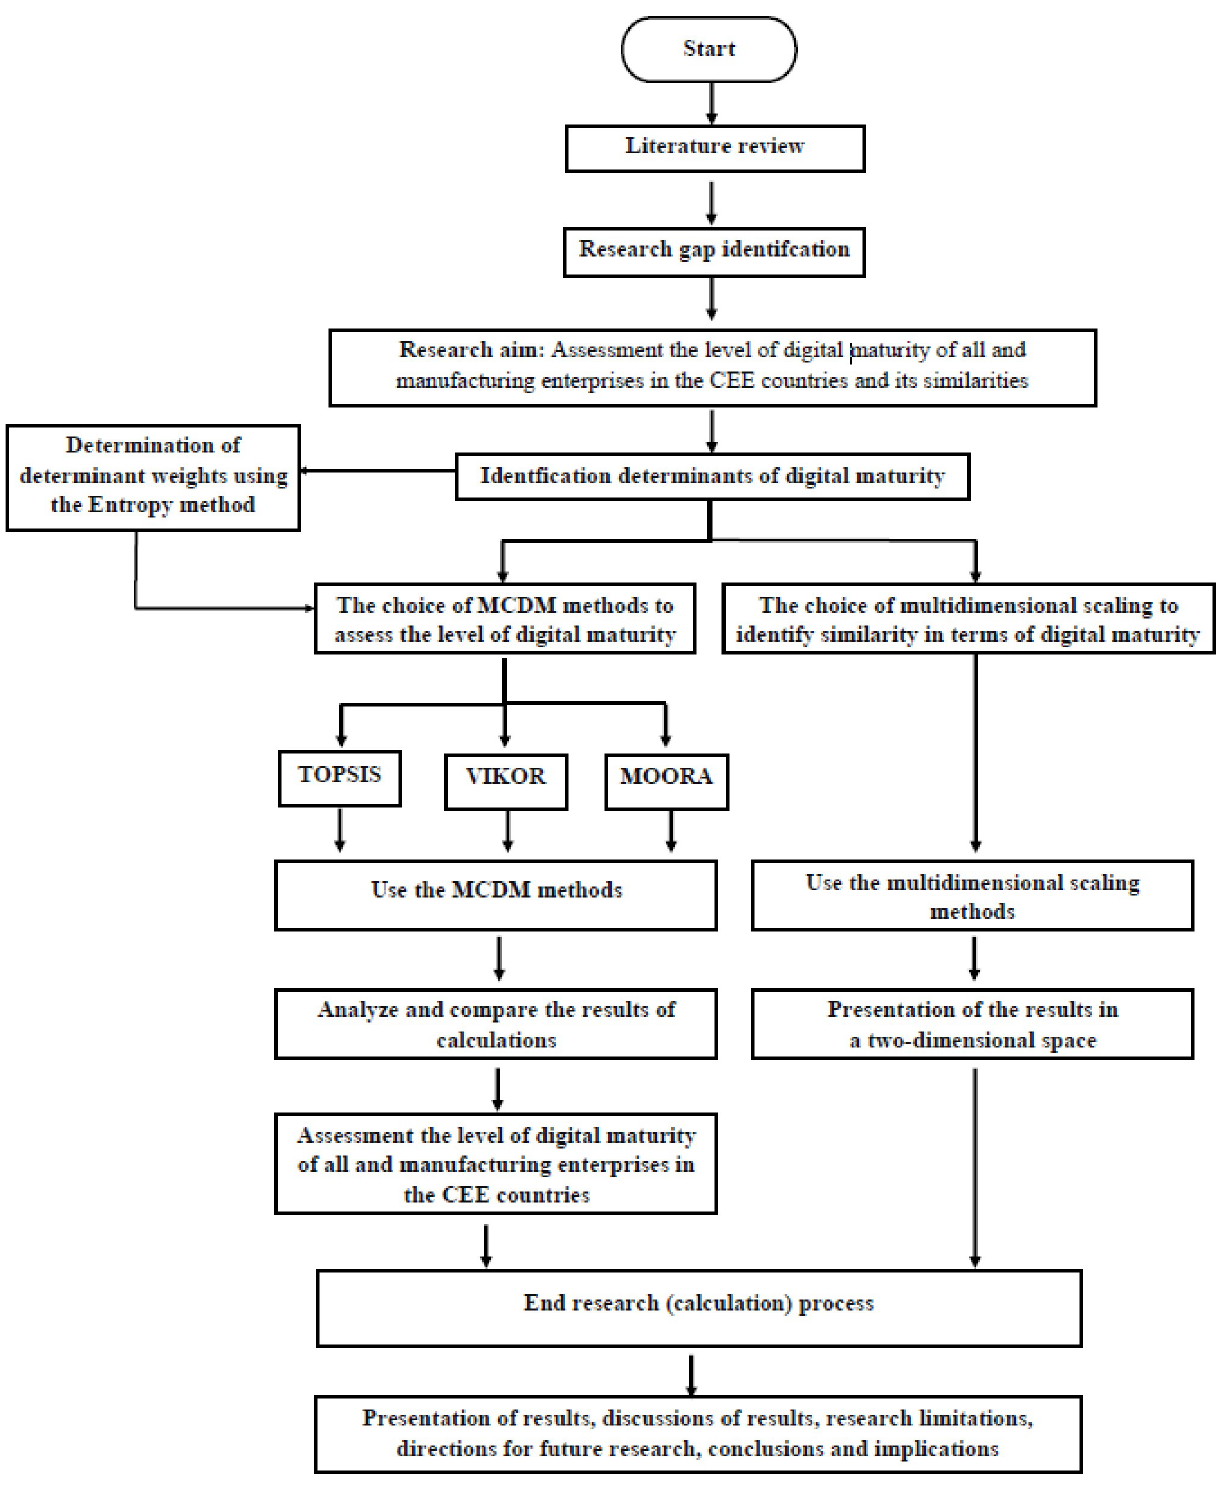
Fig 1. Research scheme.